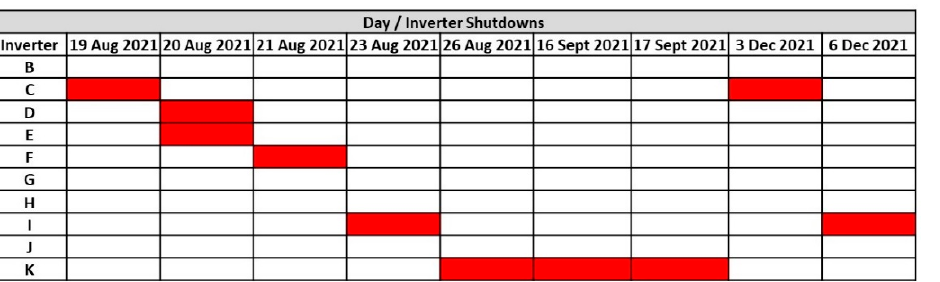
Figure 15. Inverter shutdown failures (colored in red) detected over the period from August to December 2021.